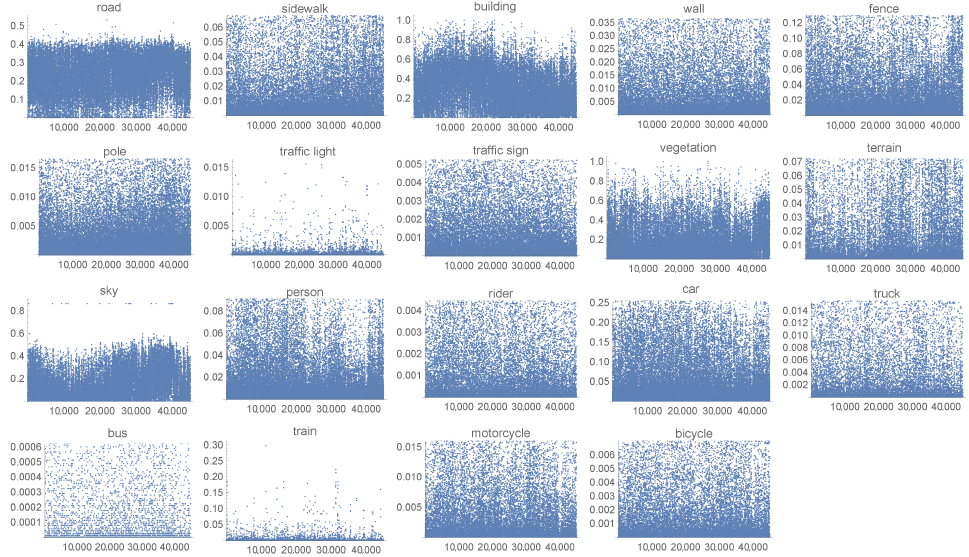
Figure 5. The scatterplots for visualizing the percentage of the segments from all the samples.